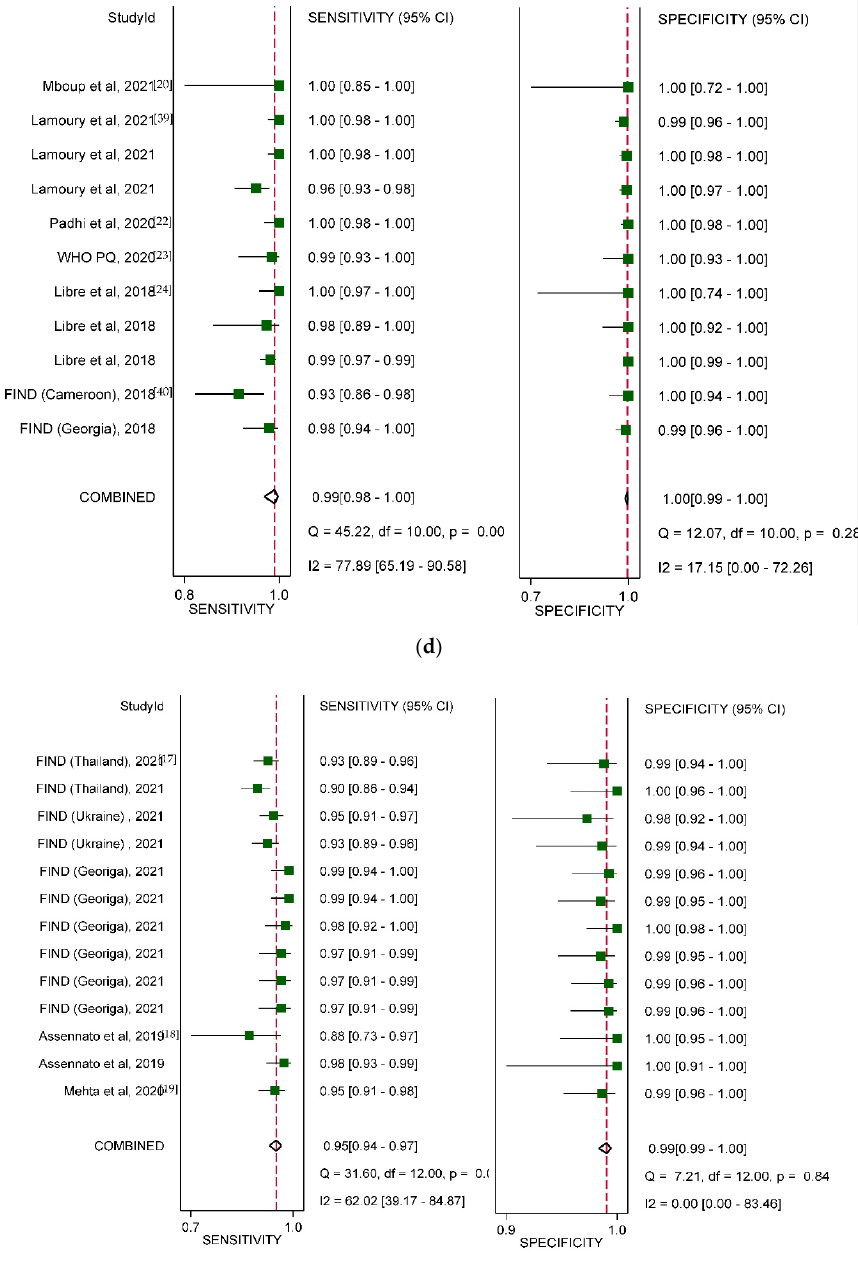
Figure 4. ( a ) Meta–analysis of diagnostic accuracy (sensitivity and specificity) for point–of–care HCV RNA assays for the diagnosis of chronic HCV infection (62 data sets from 25 studies). ( b ) Meta–analysis of diagnostic accuracy (sensitivity and specificity) for point–of–care HCV RNA assays for the diagnosis of chronic HCV infection (Xpert HCV Viral Load) (13 data sets from 12 studies). ( c ) Meta–analysis of diagnostic accuracy (sensitivity and specificity) for point–of–care HCV RNA assays for the diagnosis of chronic HCV infection (Xpert HCV VL Fingerstick) (25 data sets from 6 studies). ( d ) Meta–analysis of diagnostic accuracy (sensitivity and specificity) for point–of–care HCV RNA assays for the diagnosis of chronic HCV infection (Genedrive HCV ID kit) (11 data sets from 6 studies). ( e ) Meta–analysis of diagnostic accuracy (sensitivity and specificity) for point–of–care HCV RNA assays for the diagnosis of chronic HCV infection (Truenat and SAMBA) (13 data sets from 3